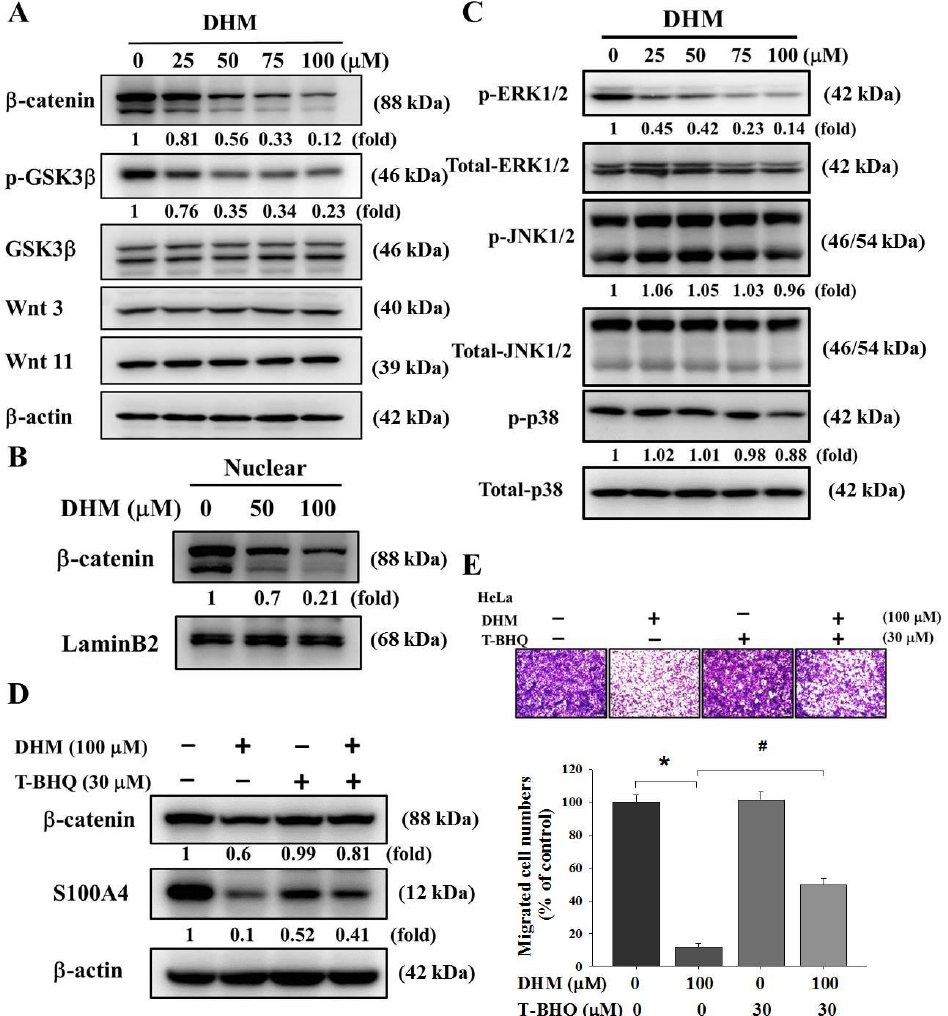
Figure 5. Effects of DHM on β -catenin, p-GSK3 β , and MAPK pathway level. ( A ) HeLa cells were seeded onto a 6 cm dish and treated with DHM (0, 25, 50, 75, 100 µ M). The results were analyzed by Western blotting. ( B ) HeLa cells were seeded onto a 10 cm dish and treated with DHM (0, 50, 100 µ M). The results were analyzed by Western blotting. ( C ) HeLa cells were seeded onto a 6 cm dish and treated with DHM (0, 25, 50, 75, 100 µ M) and assessed for the phosphorylation status of ERK1/2, JNK1/2, and p38-MAPK by Western blotting with indicated antibodies. ( D ) HeLa cells were seeded onto a 6 cm dish and treated with DHM (0, 100 µ M) for 1h and co-treatment with T-BHQ (30 µ M) for 23 h. The results were analyzed by Western blotting. ( E ) HeLa cells were seeded onto a 6 cm dish and treated with DHM (0, 100 µ M) for 1h and co-treatment with T-BHQ (30 µ M) for 23 h. The results were analyzed by Boyden chamber assay (*, p < 0.05 compared with untreated; #, p < 0.05 compared with T-BHQ 0 µ M). Cells were photographed using microscope (100 ×